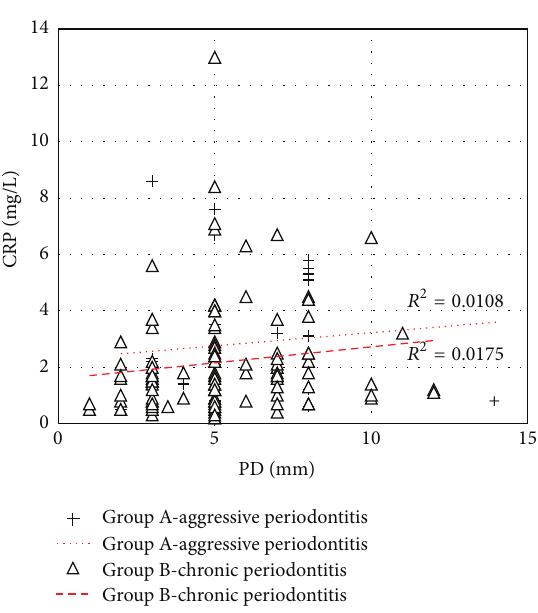
Figure 3: Statistical correlations between PD and CRP levels in Group A and Group B. ( 𝑅 2 : coefficient of